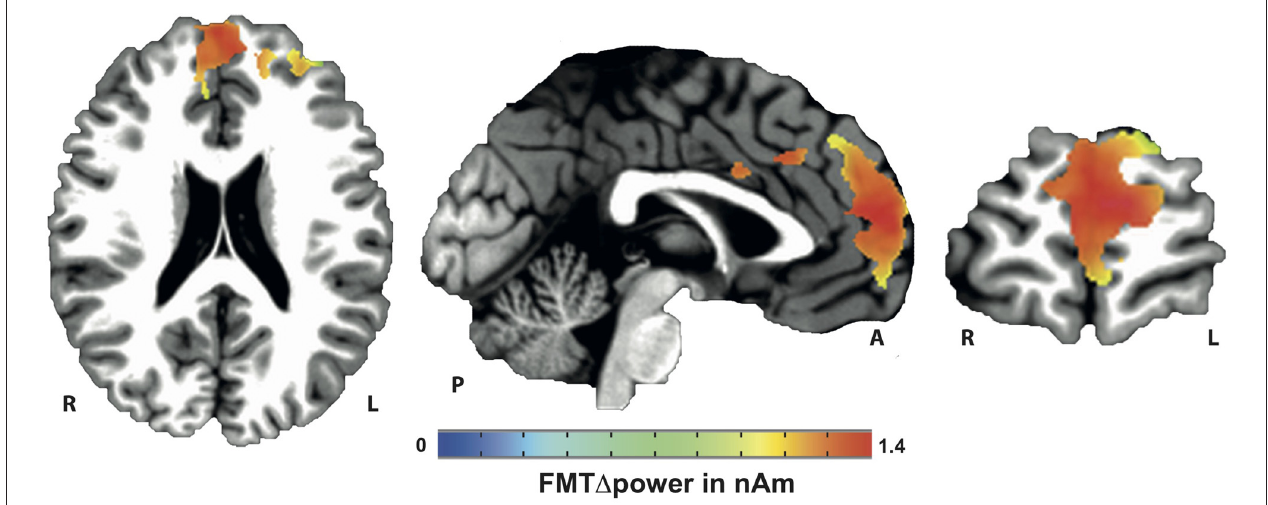
FIGURE 4 | Mapping of FMT power increase (FMT ∆ power) during execution of a 2-back task .